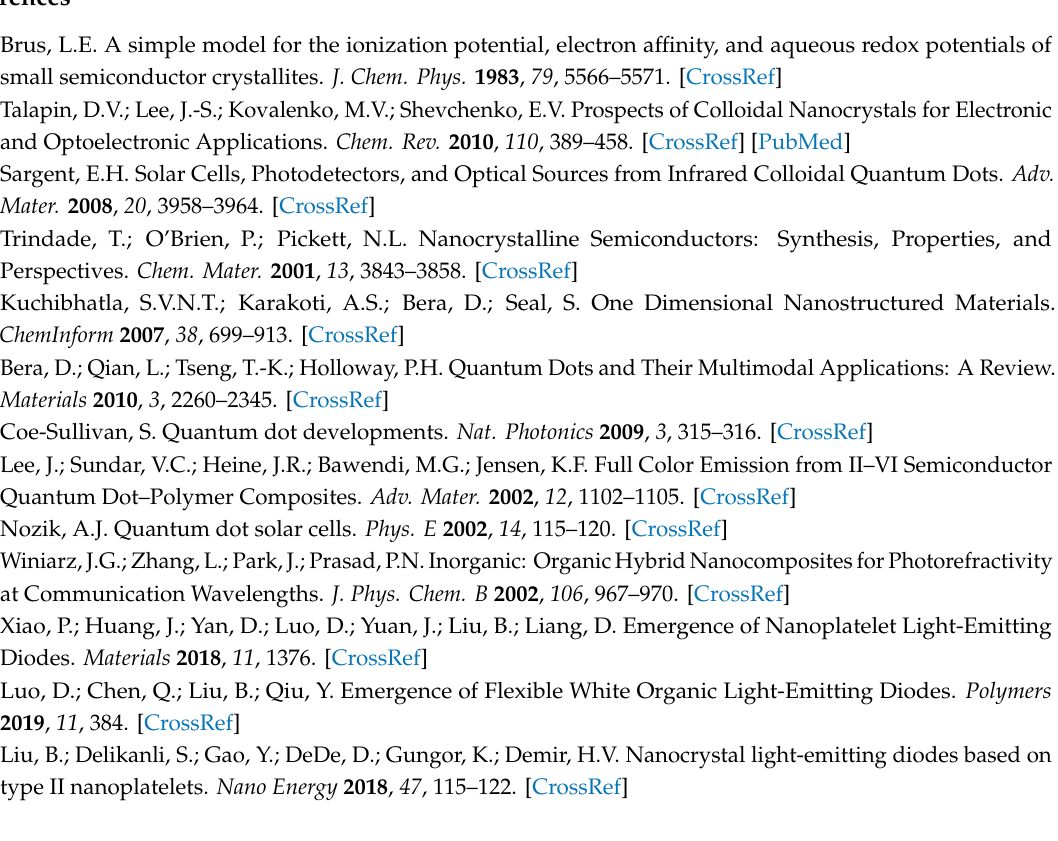
Table S1: Preparation of QD films by hydro-silylation; Figure S1: Thicknesses of the fabricated QD films. All of the films fabricated with 2 µ m of thicknesses. (a) QD-Acrylate bonded to siloxane film (b) QD-OA in siloxane film (c) QD-Acrylate in PMMA and (d) QD-OA in PMMA film; Figure S2: Schematic cartoon of the synthetic route and structure of the modified QD. Acrylate-terminated ligands were substituted with 38.8 mol% on surface of the QD; Figure S3: (a) PL and (b) absorption spectra of QDs; Figure S4: Size and shape of QDs (TEM images) (a) QD-OA, (b) QD-OH and (c) QD-Acrylate; Figure S5: Decreasing PL peaks during storage in 85 ◦ C / 85% RH condition. (a) QD-OA embedded in PMMA matrix (b) QD-OA embedded in siloxane matrix (c) QD-Acrylate embedded in PMMA matrix and (d) QD-Acrylate bonded to siloxane matrix; Figure S6: (a) Hemisphere type PL detector and customized LED having same sized with the sample holder. (b) The stability against luminous flux proceeded together at once; Figure S7: X-ray di ff raction of QD-OA. It shows typical zinc blende crystal structure of